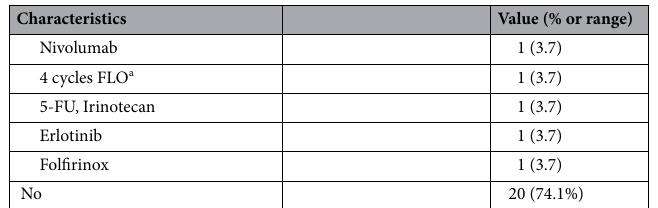
Table 2. Treatment characteristics 1st and 2nd SBRT. a Administered 1 week post Radiation for a synchronous stomach cancer. PTV, planned target volume; KPS, Karnofsky performance status; Anti-TIM3, anti-T-cell immunoglobulin and mucin domain-3; Anti-PD1, anti-programmed cell death protein-1; EGFR, epidermal growth factor receptor; FLO, 5-Fluorouracil, Folinic acid and Oxaliplatin; Folfirinox, Fluorouracil, Folic acid, Irinotecan,